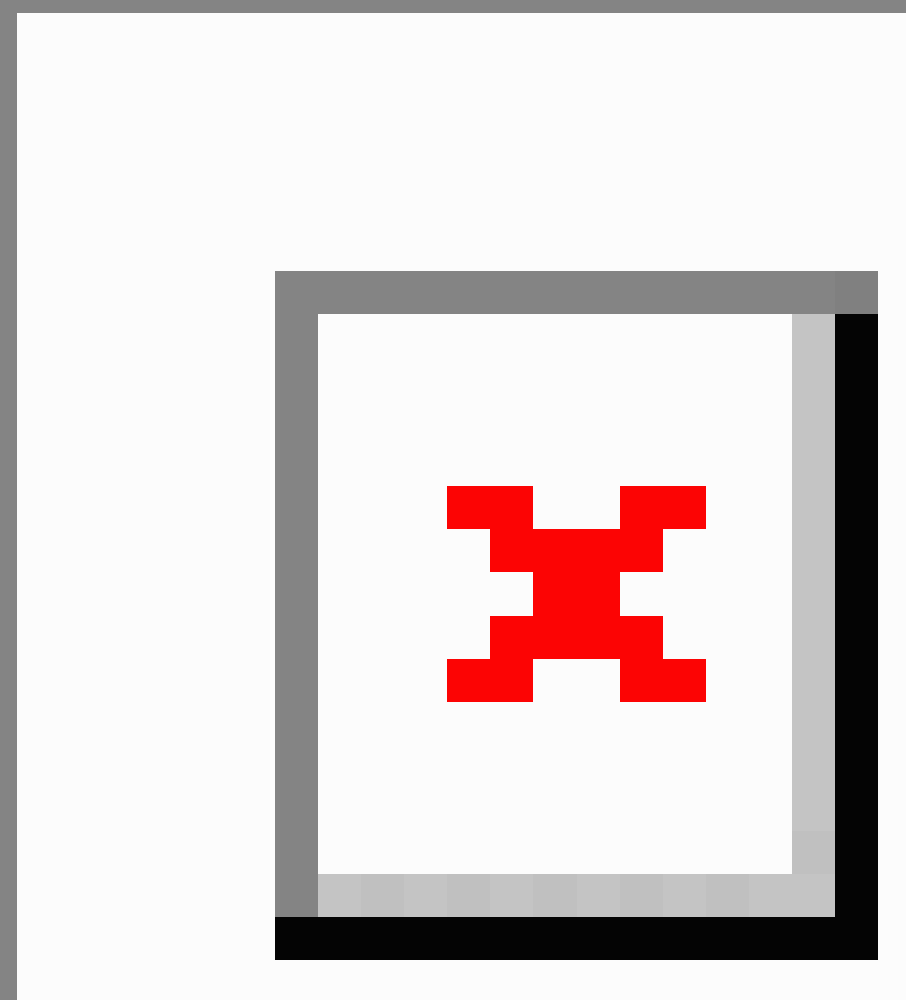
Figure 4. Mobile version of the Activate Your Heart